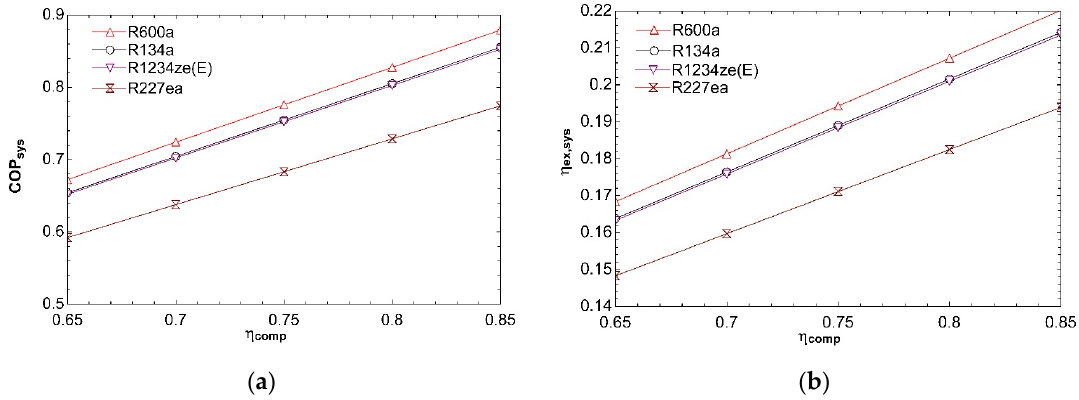
Figure 5. Impact of η comp on COP sys ( a ) and ƞ ex,sys ( b ) in combined ORC-single evaporator VCR cycle.